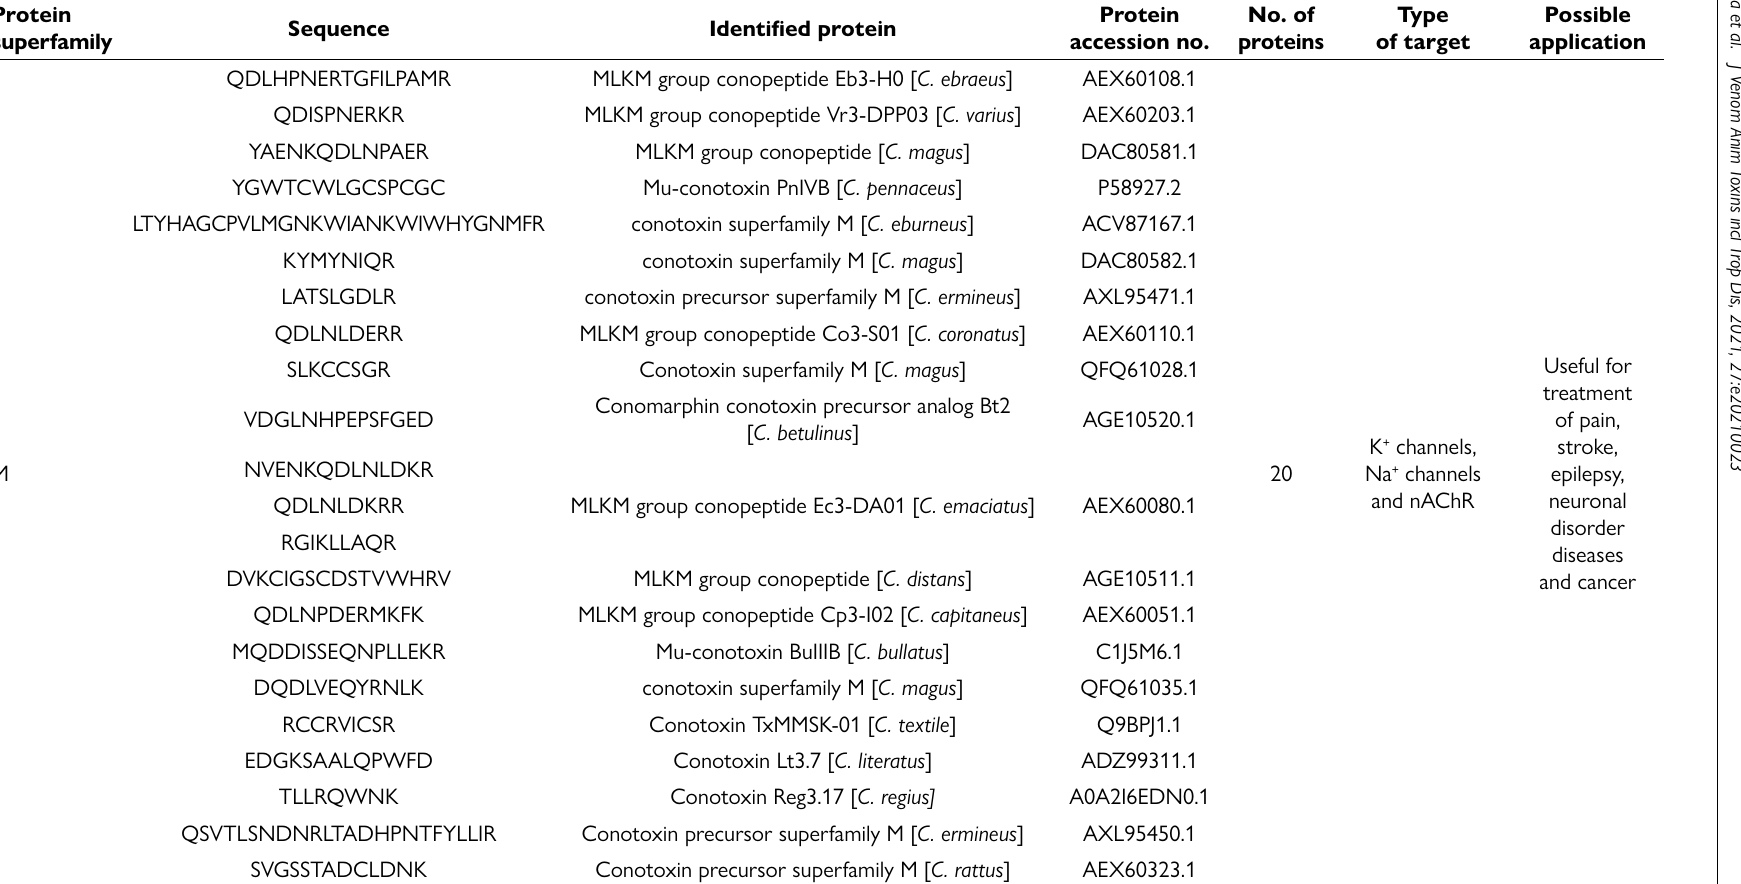
Table 1. Protein